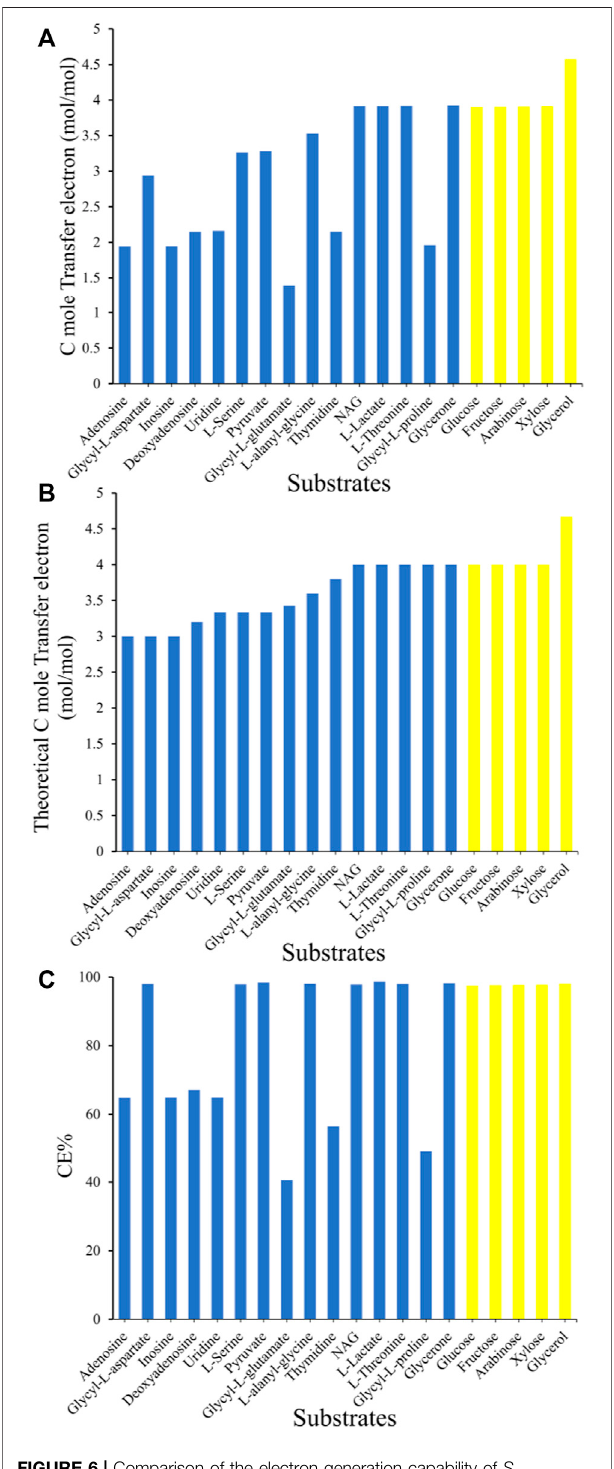
FIGURE 6 | Comparison of the electron generation capability of S. oneidensis MR-1 with 20 different carbon sources in silico . (A) The simulated electron generation rate per C-mole substrate. (B) The inherent electron numbers per C-mole substrate. (C) The Coulombic ef fi ciency (CE). The blue columns indicate substrates that are naturally utilized by MR-1, and the yellow columns indicate substrates that require the introduction of heterologous utilization